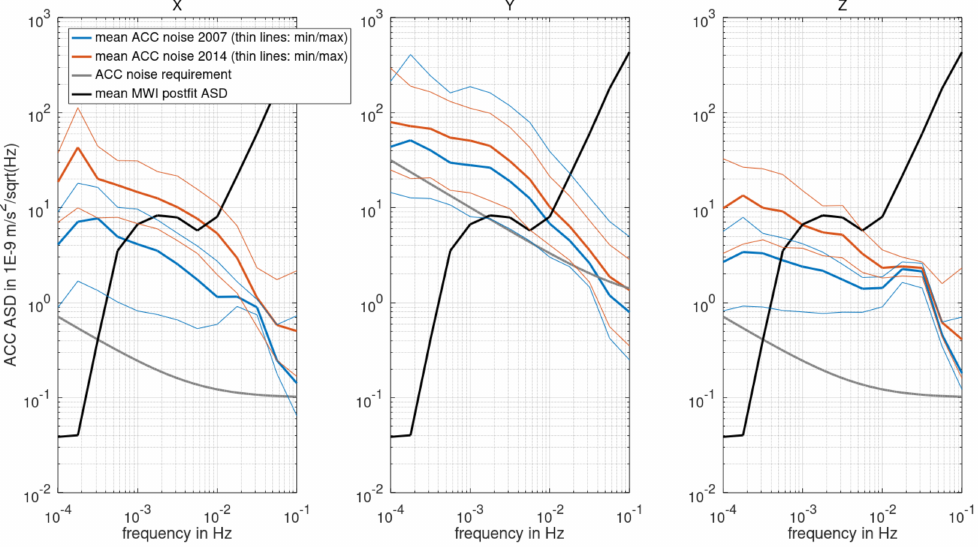
Figure 4. Mean annual smoothed noise ASDs of the GRACE ACCs for 2007 (blue, thick lines are the mean; thin lines the min/max) and 2014 (red) for X ( left ), Y ( middle ), Z ( right ), in comparison with the ACC noise specifications (gray) and the mean MWI post-fit ASDs (black, cf. Figure